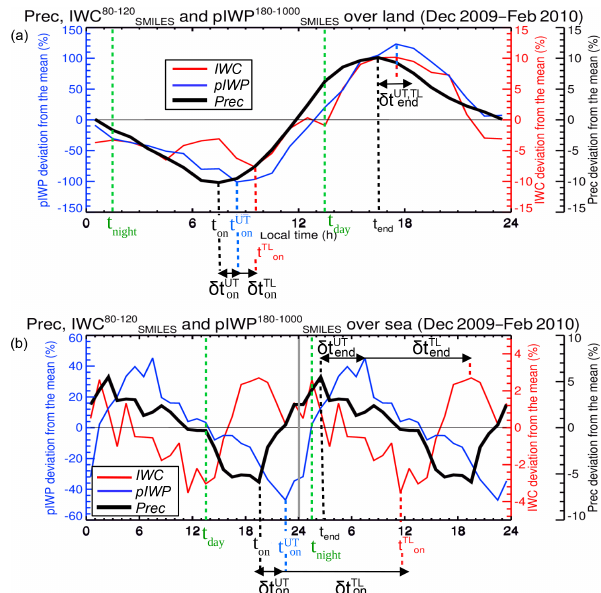
Figure 11. Deviation from the mean (%) of the diurnal cycle of par- tial ice water path (pIWP; integrated between 1000 and 180hPa), ice water content (IWC; averaged between 80 and 120hPa) mea- sured by SMILES, and precipitation (Prec) over (a) the tropical land (0–30 ◦ S) and (b) tropical ocean (0 ◦ N–30 ◦ S) from December 2009 to February 2010. t on , t UT on , and t TL on are the onsets of the Prec, pIWP, and IWC increase, respectively. t end is the end of the Prec increase. δt UT on and δt TL on are the delays between t on and t UT on and t TL on , respec- tively, and δt UT and δt UT are the delays between t end and the end of end end the pIWP and IWC increase, respectively. Data have been smoothed out using a 6h running